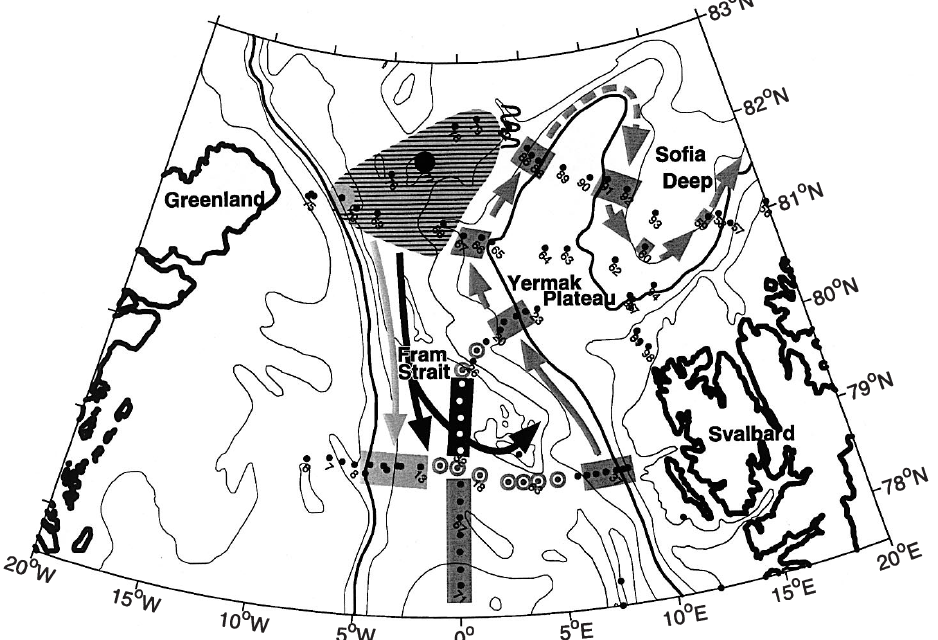
Fig. 15. Horizontal distribution of deep water masses. Dark gray shading shows the presence of NSD. Light gray denotes EBDW and black (as well as black hatching ) shows overlying CBDW. Arrows denote proposed pathways of the di(cid:128)erent waters. Circles show stations with mixed deep water masses. The wriggly line indicates interleaving be- tween converging